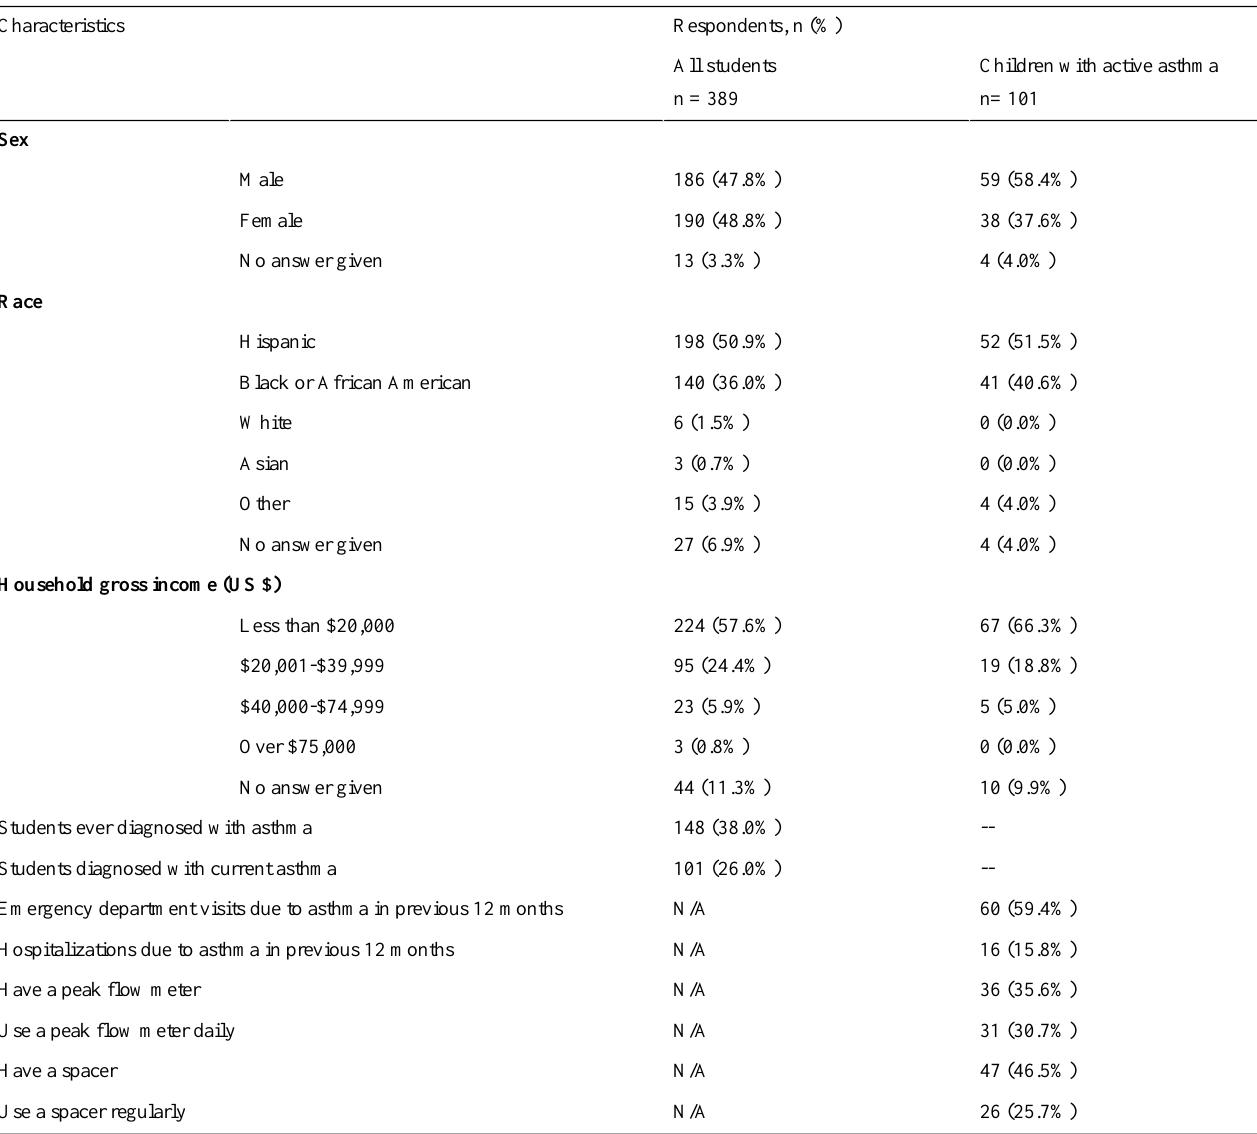
Table 1. Characteristics of students who completed the needs assessment